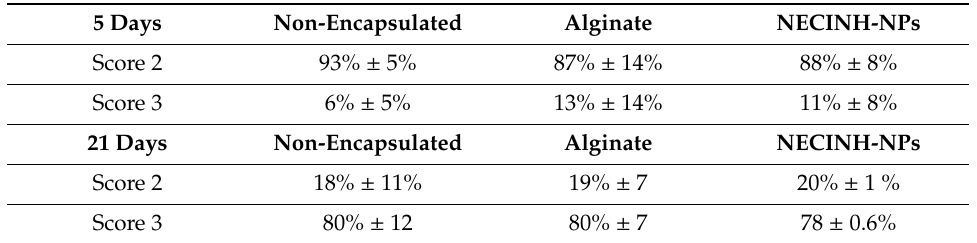
Table 1. Impact of NECINH-nanoparticles (NPs)-loaded hydrogel on mice testicular tissue exposed to hypoxia (1% O 2 ) for 5 and 21 days. Results for tissue integrity are expressed as the mean percentage of seminiferous tubules for each integrity score and condition ± standard deviation.